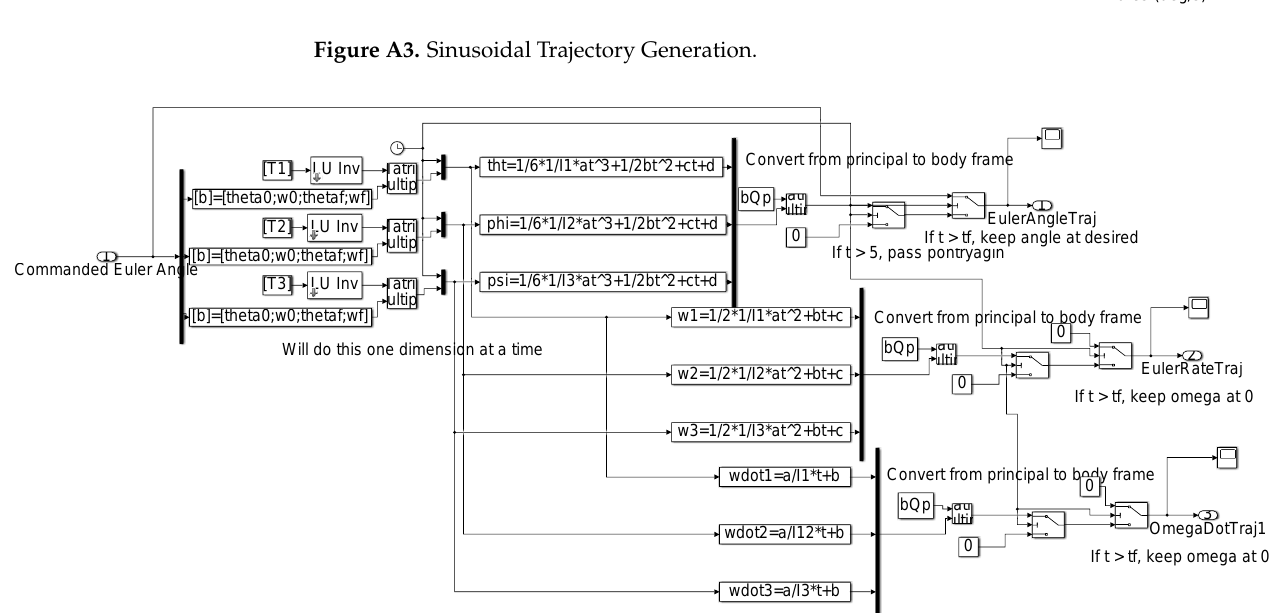
Figure A4. Pontryagin based Trajectory Generation.